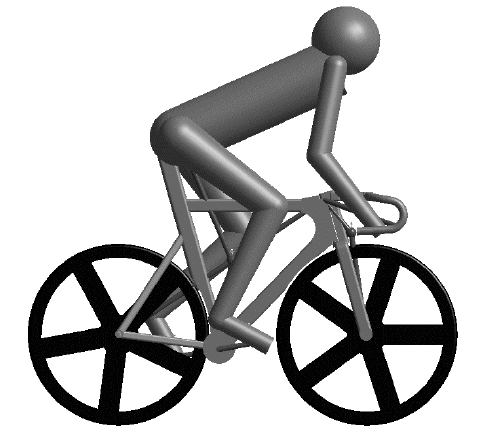
Figure 1. MapleSim model of a cyclist and bicycle consisting of eleven bodies with seven degrees of freedom. The head, arms, and trunk were fixed and therefore treated as a single